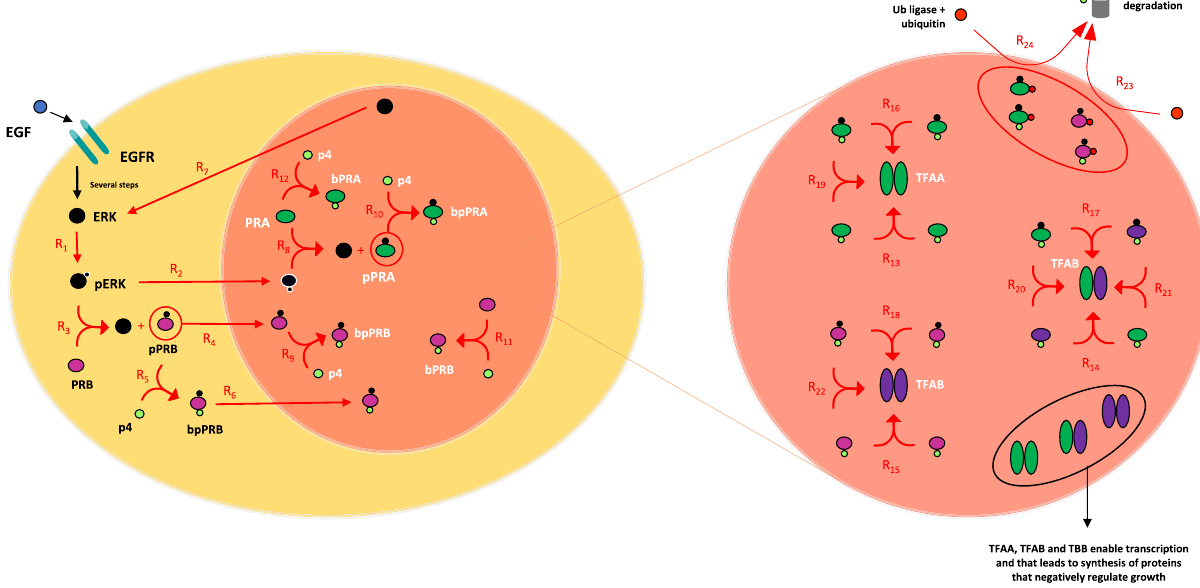
Figure 2. Illustration of the model summarizing key aspects of progesterone receptor regulation. Approximately 50% of PRB is cytoplasmic in the absence of progesterone, while PRA is considered to be 100% resident in the nucleus whether or not ligand is present 8 . Two ligand binding steps are required to maximally support PRB shuttling into the nucleus where it can form active dimerized transcription factor. In one step, growth factors bind to surface receptors, such as the EGFR, leading to the activation of the MAP kinase family members, ERK1 and ERK2. Activated ERK phosphorylates PRB. Cytosolic, phosphorylated PRB binds progesterone and translocate to the nucleus 6 . Ligand binding at this stage is not rate-limiting. On one hand, ligand binding is a relatively fast event (compared to the expected time for PR translocation). On the other, growth factors may bypass ligand activation by inducing rapid translocation to the nucleus, with ligand concentrations that are normally too low to stimulate activation without other stimuli 4 . PRA is also a substrate for ERK phosphorylation, once active MAP kinase translocates to the nucleus. Nuclear, ligand-bound progesterone receptors form hetero- and homodimers and, in endometrial tissue, stimulate transcription of genes that mediate differentiation and growth arrest. PRA and PRB are also substrates for ubiquitination, targeting receptors for translocation to the cytosol and proteosomal strual cycle, and clustered into discrete foci in the secretory phase. In contrast, in endometrial cancer cells, PRA has been observed to be predominantly evenly distributed in the nucleus whereas PRB is frequently observed in intranuclear clusters 1 . Thus, the main difference between the distributions noted in the normal and cancerous cells is the lack of an even distribution of PRB in the nucleus of cancer cells in the presence of progesterone 1 . The clusters have been described as foci, where PRB was present more than PRA and where 33% of the cases contained more than six foci per nucleus. This suggests that PRB is the principal isoform in nuclear foci. It also has been reported that when PR are in clusters, these are generally localized in regions of active chromatin, sug- gesting they represent transcriptionally active PR 7 . In normal cells, the median length of each foci was observed to be 0.75 μm with an interquartile range of 0.65–1.5 μm 1 , whereas in cancer tissues clusters exhibit a median length of 1.04 μm with an interquartile range of 0.78–1.94 μm 7 . It has been further suggested the difference in size corresponds to alterations in chromatin structure, which in turn allows for clusters to comprise a larger number or different complement of proteins than in normal tissues 7 . notable difference between normal tissue and cancer in PR formation is the relative distribution of PRA and PRB in foci, where both PRA and PRB form clusters in normal tissues but in endometrial cancers PRB was more common than PRA in foci 1 . Together with results in 7 , it was suggested there is aberrant PR cluster formation in